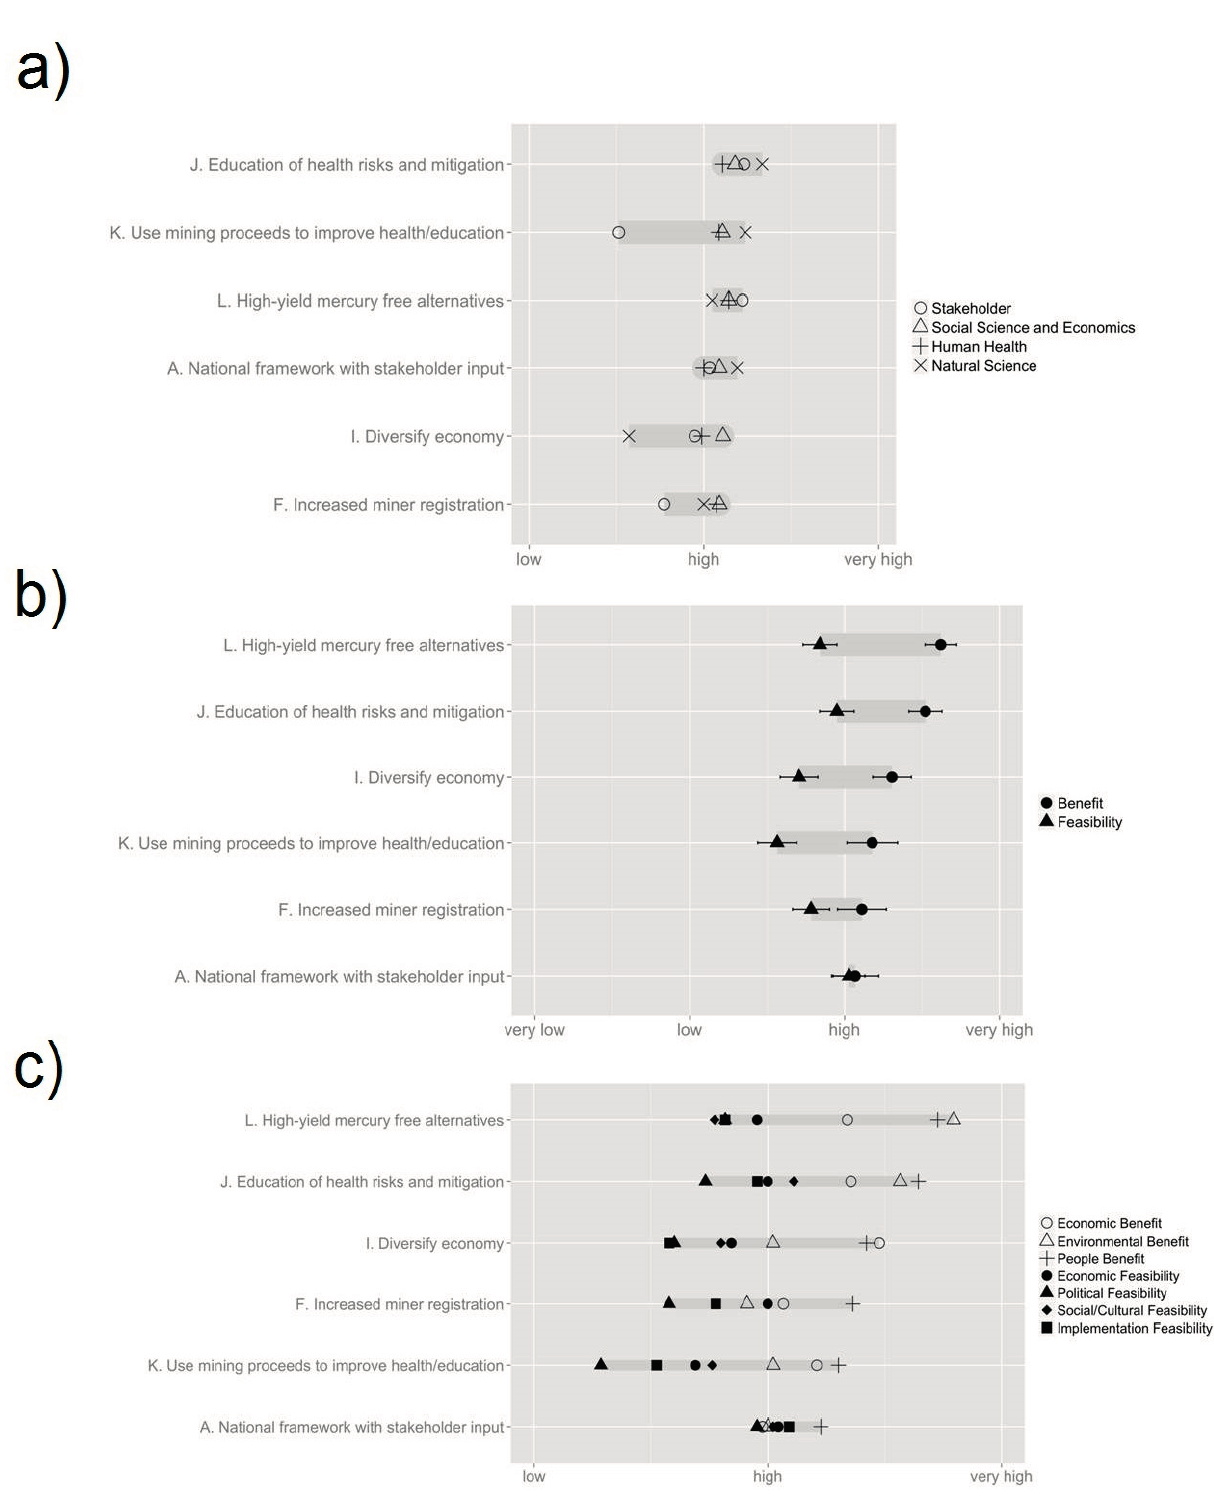
Figure 5. Delphi poll scores from the third Delphi poll, conducted among stakeholders (n = 22) in April 2015. ( a ) Overall score by workgroup; ( b ) Overall benefit and feasibility scores for all groups; ( c ) Benefit and feasibility score for each option grouped by